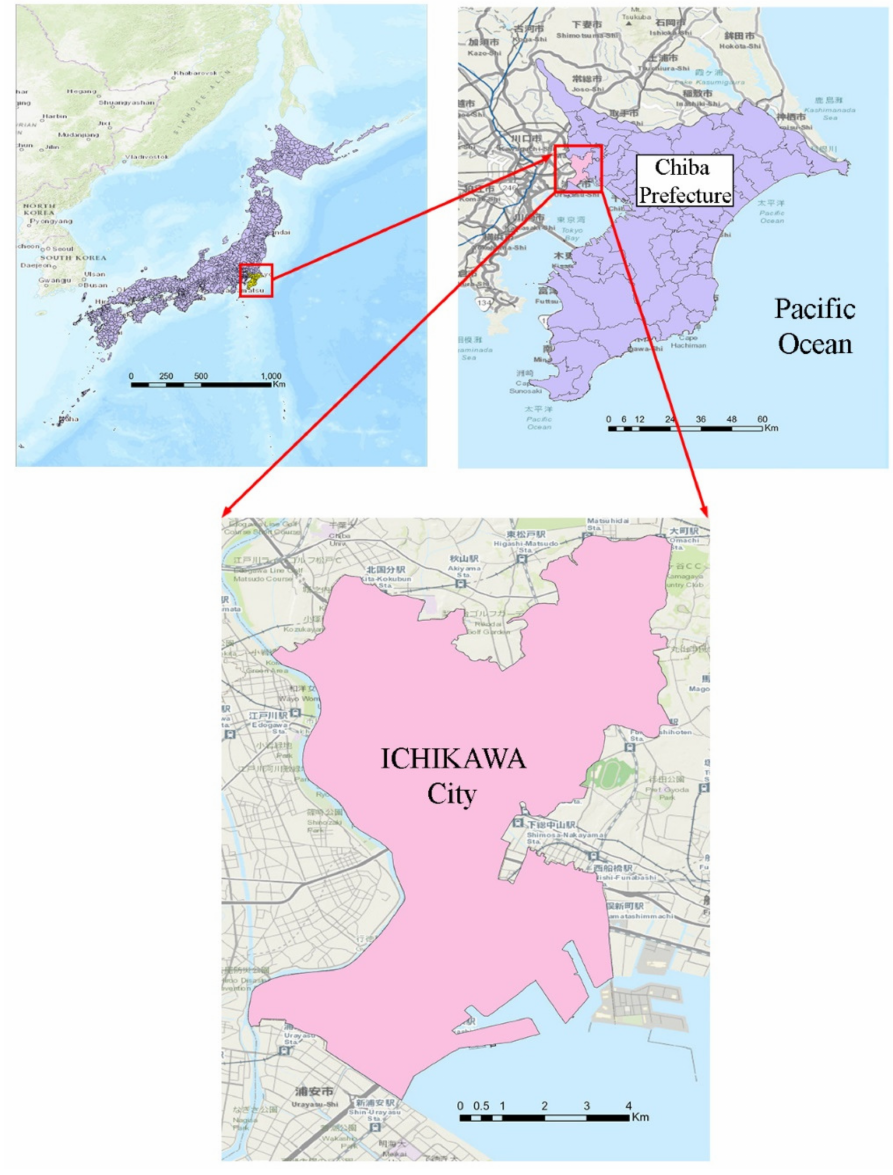
Figure 1. Location of Ichikawa in Japan. The city belongs to the Chiba Prefecture, which lies in the Kantou region of Honshu island. It is located northwest of this prefecture, next to the Tokyo metropolitan area. The city’s area is 57.45 km 2 . The locations’ Japanese names come along with English